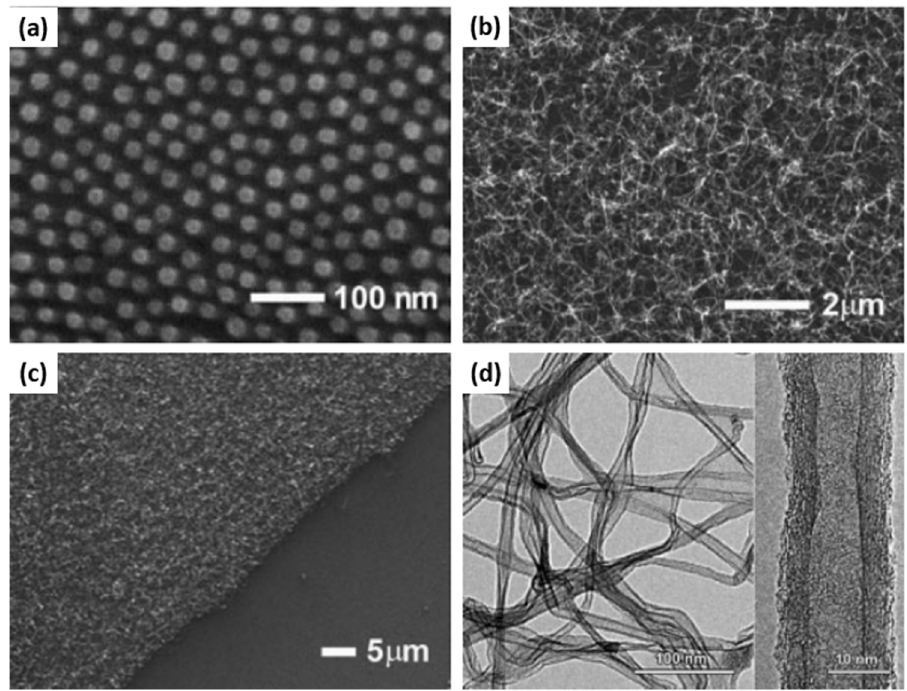
Figure 3. ( a ) SEM image iron oxide domains on a Si surface obtained by spin-coating a PS– b -PFS block copolymer followed by O 2 reactive-ion etching; ( b ) SEM image of the same surface after CNT growth for 5 min. ( c ) SEM image of the same surface as ( b ). In the lower righthand corner the polymer film was scratched before O 2 reactive-ion etching. ( d ) Medium- and high-resolution TEM images of carbon nanotubes grown as in ( b , c ). Adapted from Ref. [23].